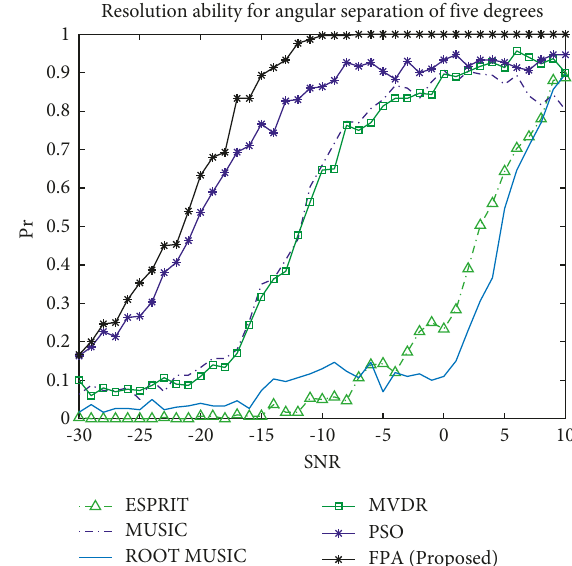
Figure 23: Probability of resolution for the source at 30 degrees.